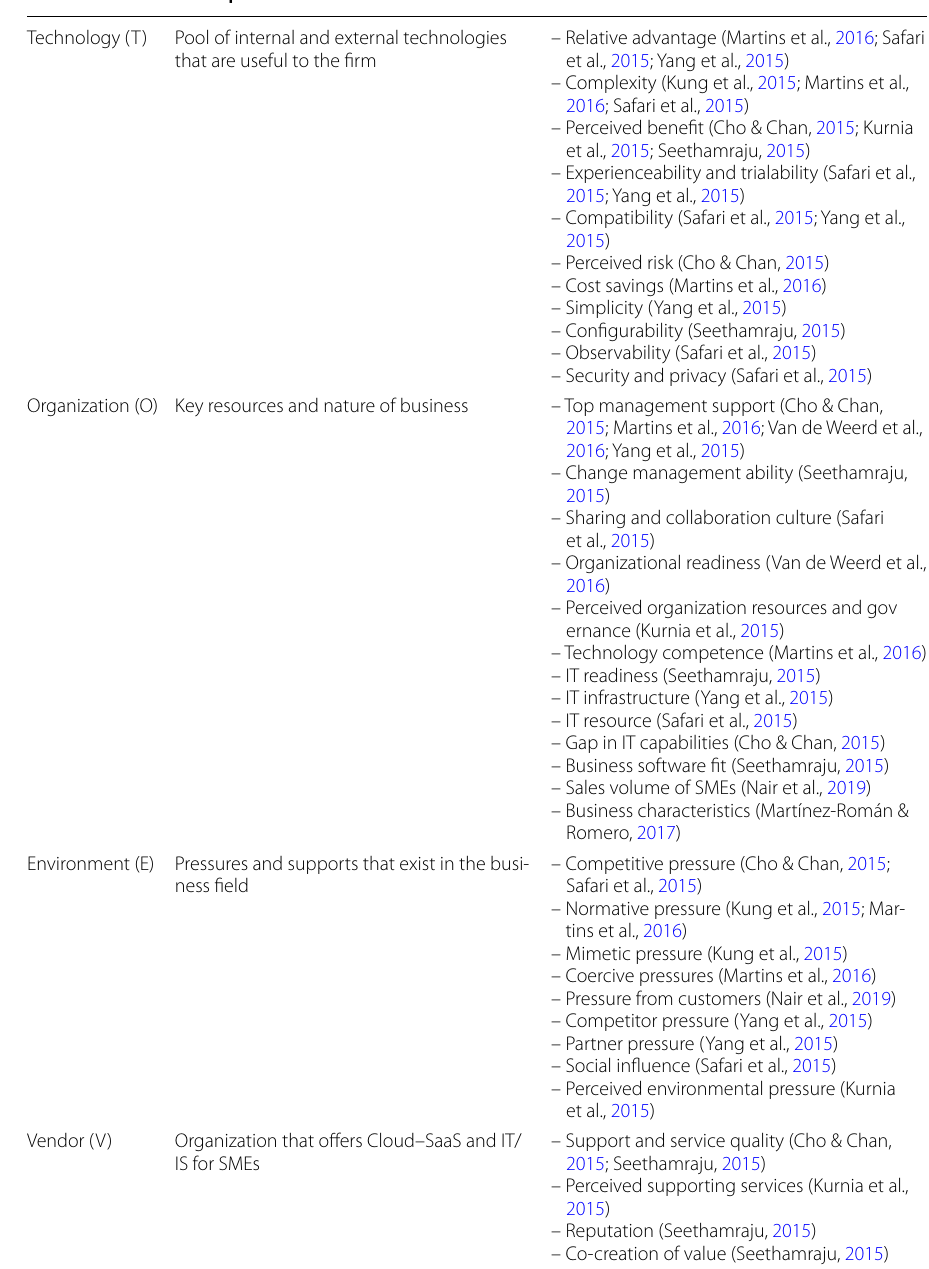
Table 4 Previous studies that use technology, organization, environment, vendor, and owner